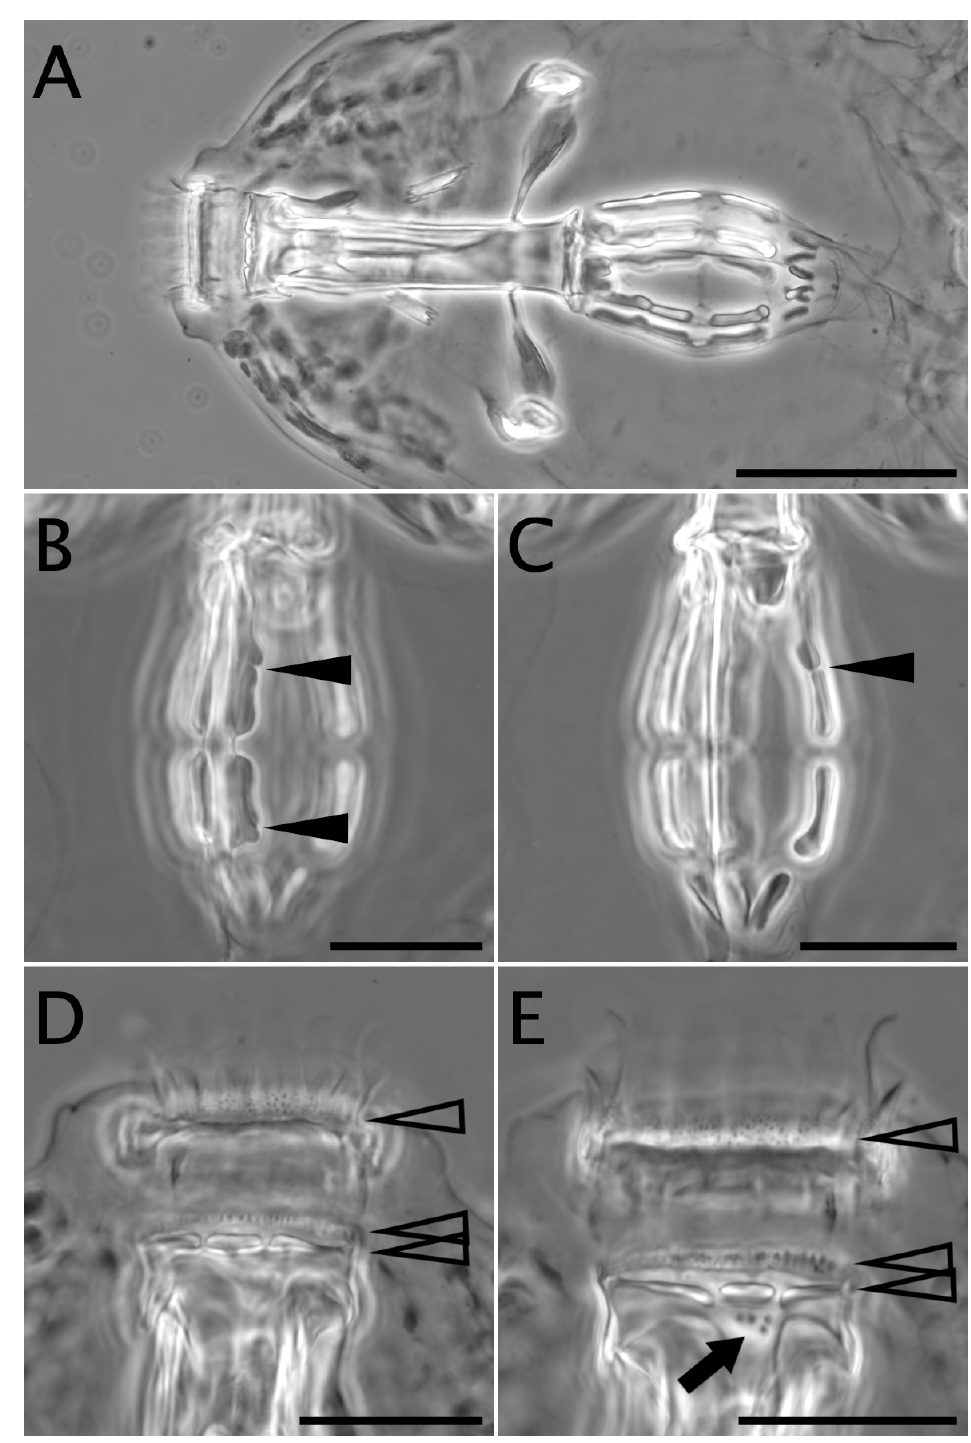
Fig. 4. Sisubiotus hakaiensis sp. nov., buccal-pharyngeal apparatus in PCM. A, D–E . Paratype (JYUt. S1911_SL4_C). B–C . Paratype (JYUt.S1911_SL2_B). A . In toto buccal-pharyngeal apparatus. B–C . Placoids, arrowheads indicate constrictions in the macroplacoids. D *. Dorsal Oral Cavity Armature (OCA), empty arrowheads indicate the three bands of the OCA. E *. OCA, empty arrowheads indicate the three bands of the OCA. Deep-focus images obtained by stacking are indicated in the figures caption with an asterisk (*). Scale bars: A = 50 μm; B–E = 20